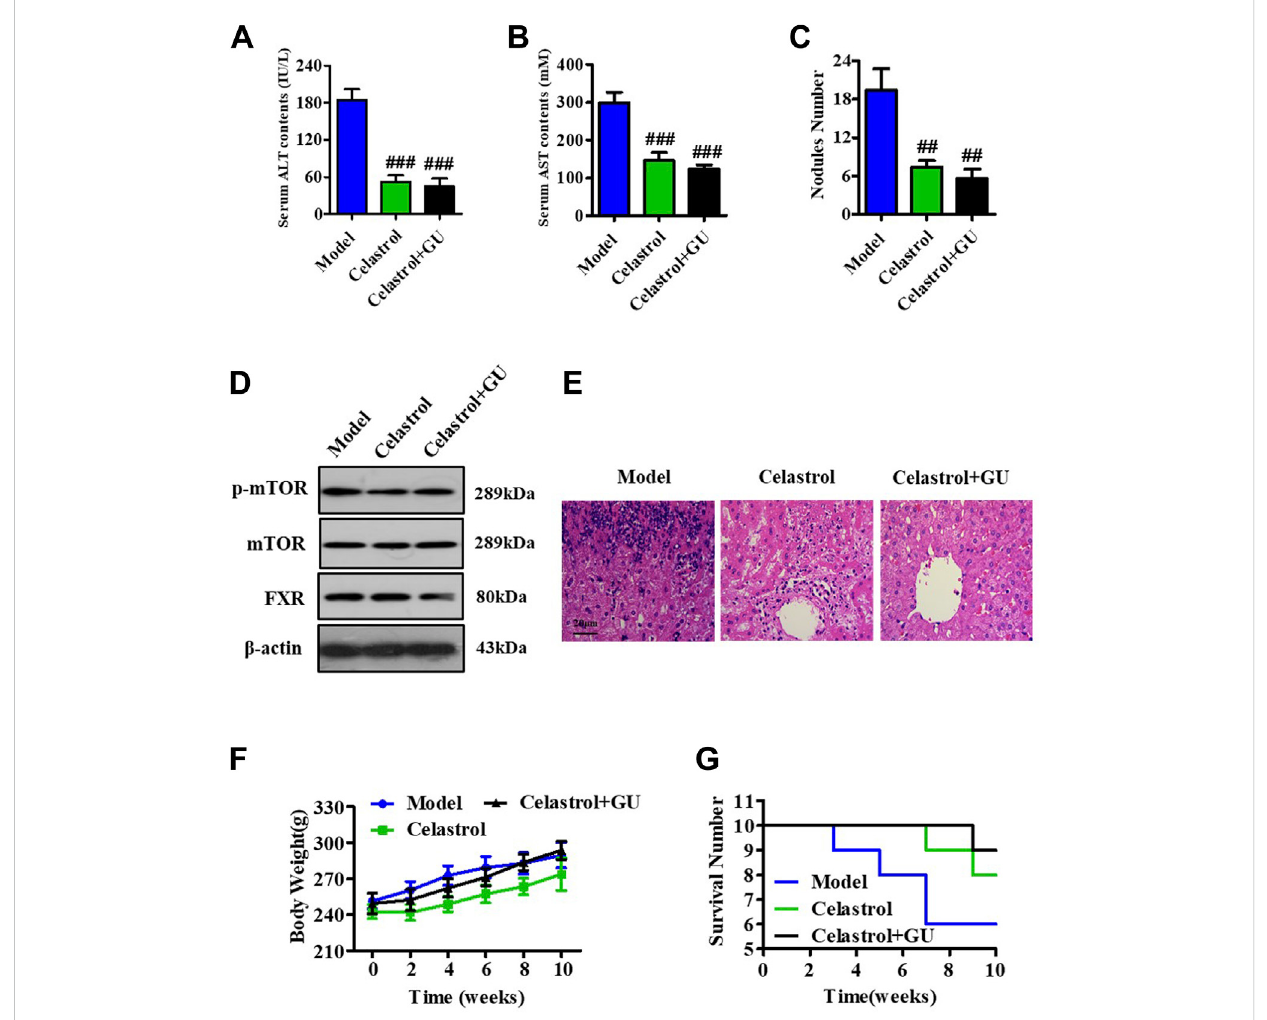
FIGURE 7 GUDCA improves the alleviating effect of celastrol on HCC in an orthotopic rat model. Serum levels of (A) ALT and (B) AST; (C) Nodule numbers of liver tissue; (D) Western blot for probing the expressions of p-mTOR, mTOR, and FXR; (E) H&E staining for pathology analysis; (F) The curve of